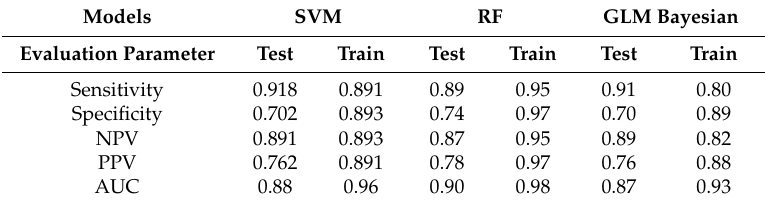
Table 4. Predictive capability of piping models using train and test dataset.